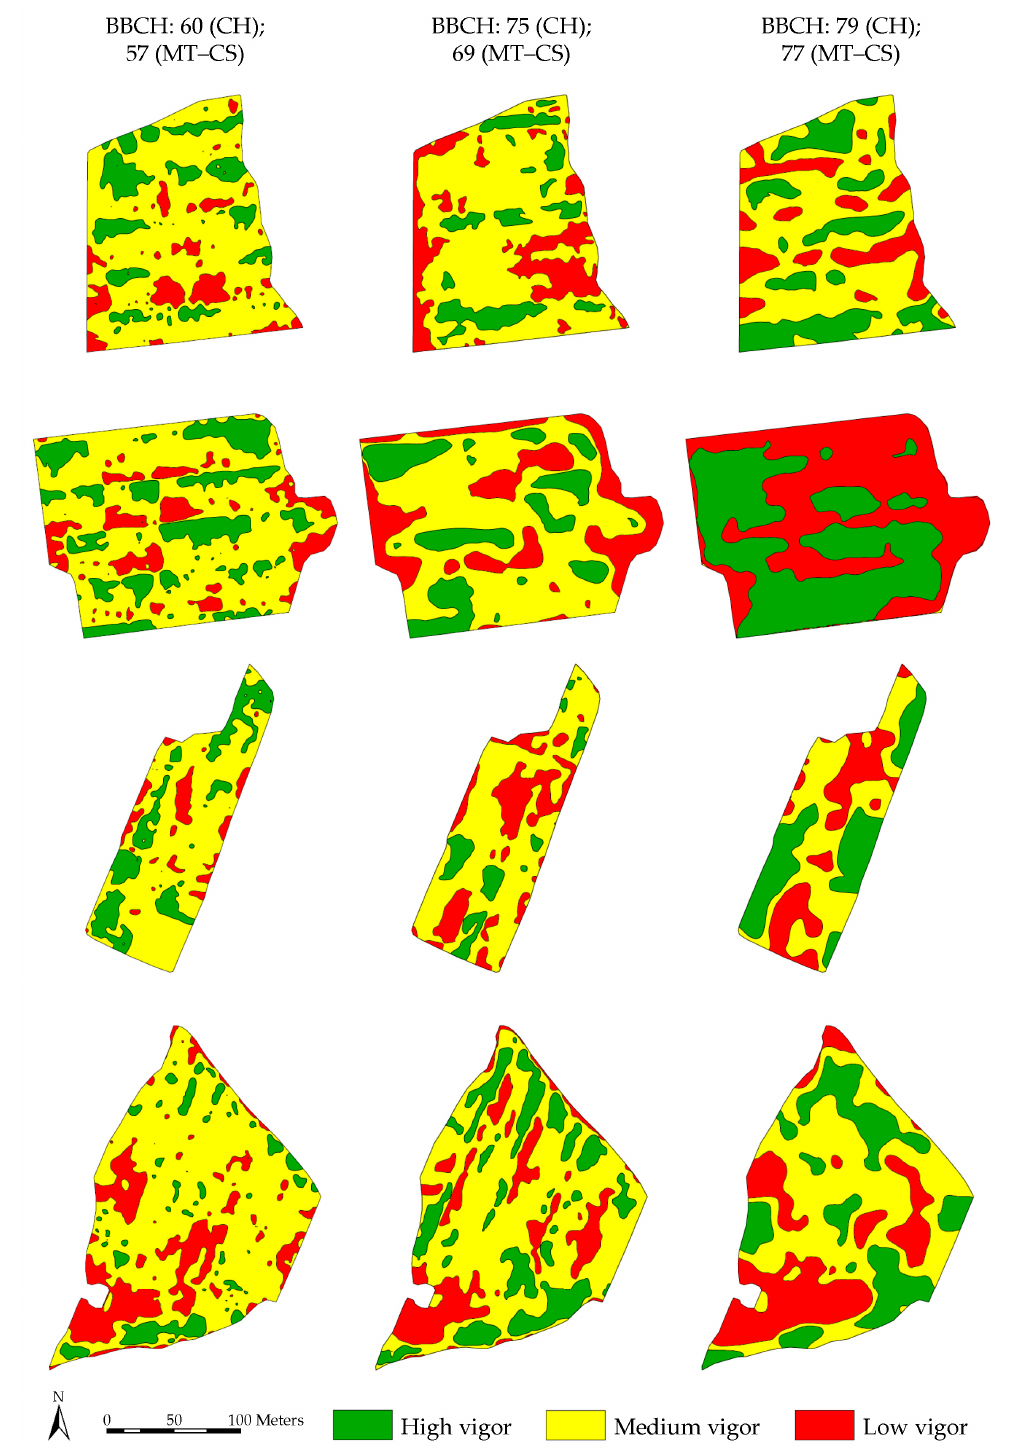
Figure 5. Vigor maps for each parcel in the evaluated BBCH stages.